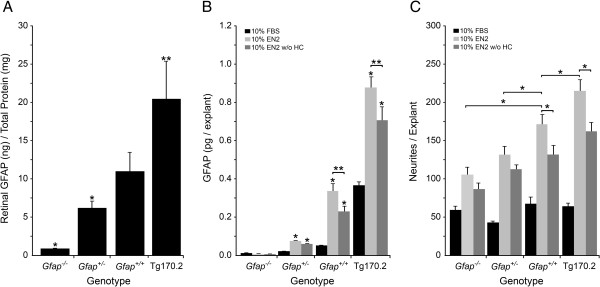
GFAP levels are positively associated with neurite outgrowth under growth stimulatory conditions. Histographs showing from different mouse genotypes at PN7 (A) the amount of retinal GFAP (mean±SEM), (B) GFAP levels (mean±SEM) in PN7 retinal explants cultured 7 days with either 10% FBS, 10% EN2, or 10% EN2 w/o HC, and (C) neurites per explant (mean±SEM) in PN7 retinal explants cultured for 7 days with 10% FBS, 10% EN2, or 10% EN2-HC. (A) The amount of GFAP in different mouse genotypes shows titration of GFAP from background levels (Gfap-/-, *P<0.001 versus Gfap+/+ retinas), to half the amount of GFAP (Gfap+/-, *P=0.048 versus Gfap+/+ retinas), to double the amount of GFAP (Tg170.2, **P=0.041 versus Gfap+/+ retinas). (B) In retinal explants cultured for 7 days the same relationship between GFAP levels and genotype was maintained, regardless of culture conditions (*P<0.05), although overall GFAP levels were significantly higher in explants cultured in EN2 versus EN2 w/o HC treated explants (**P<0.03). (C) None of the FBS treated explants had significant neurite outgrowth, indicating that increased GFAP alone does not increase neurite outgrowth. EN2 and EN2 w/o HC treated explants had increased neurites in all strains compared to FBS. In Gfap+/+ and Tg170.2 explants, there were significantly more neurites in EN2 treated explants than EN2 w/o HC treated explants. In Gfap-/- and Gfap+/- explants, this treatment dependent effect was ablated, indicating that one important contribution of HC to increased neurite outgrowth is the increase in GFAP. Bracketed comparisons are significantly different (P<0.05).